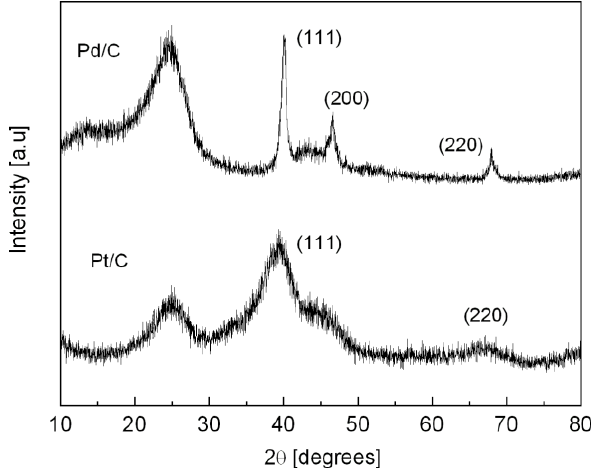
Figure 1. X-ray patterns of home-prepared Pd/C and commercial